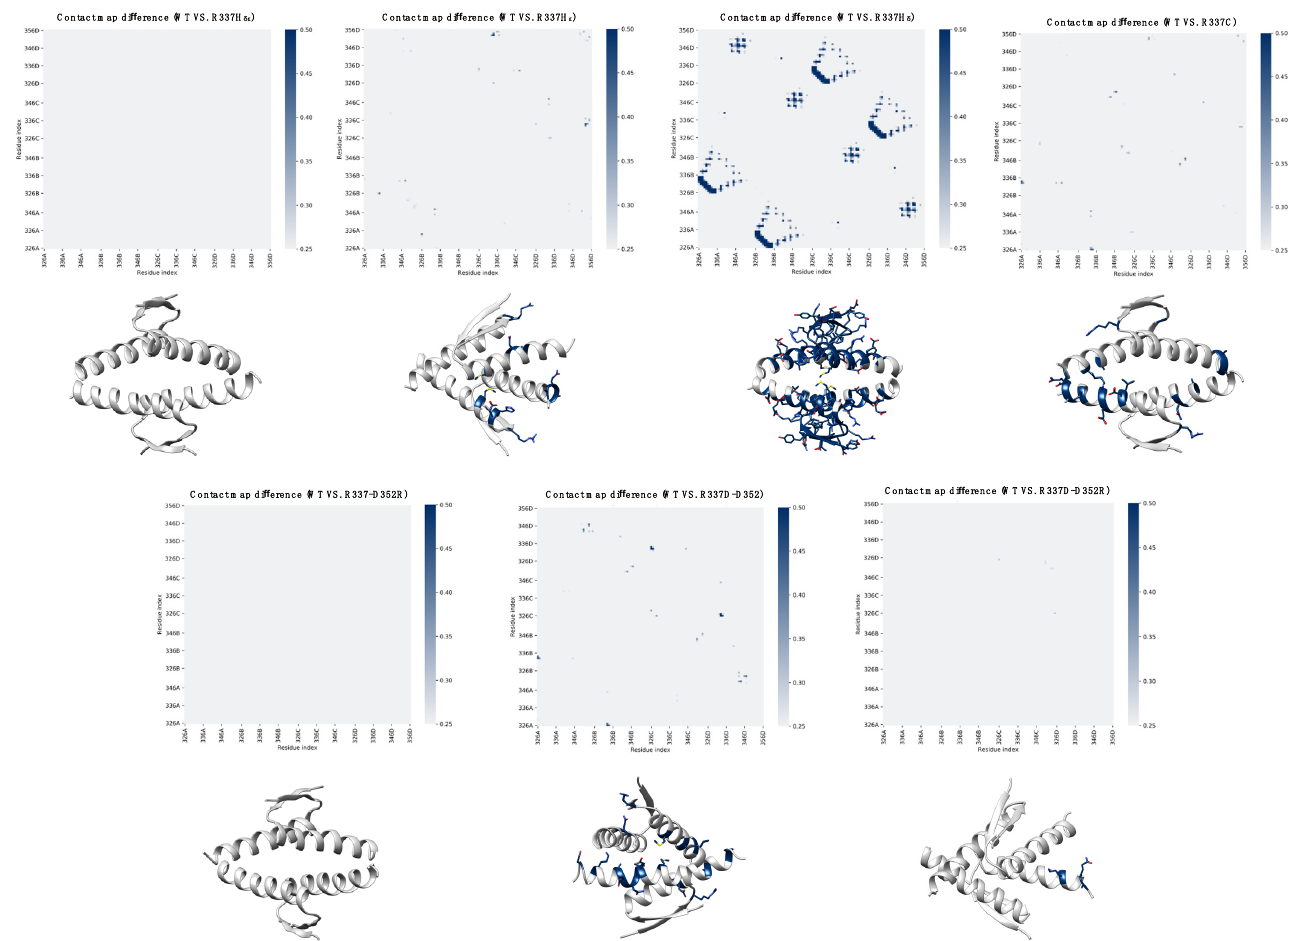
Figure 4. Contact map analysis of WT and mutant p53 TET domain. The average contact map difference is represented as a residue index matrix for each form. Mutant p53 forms are expressed as the absolute value of the difference with the WT protein. The contact maps of R337C, R337D/D352R, R337D, R337H ε , and R337H δ show a significant variation, with the latter presenting the largest divergence. In contrast, D352R and R337H δε displayed no substantial deviation from the WT. The side chains of residues with the most evident differences in each contact map, defined by a threshold between 0.25 and 0.5, are illustrated as sticks.